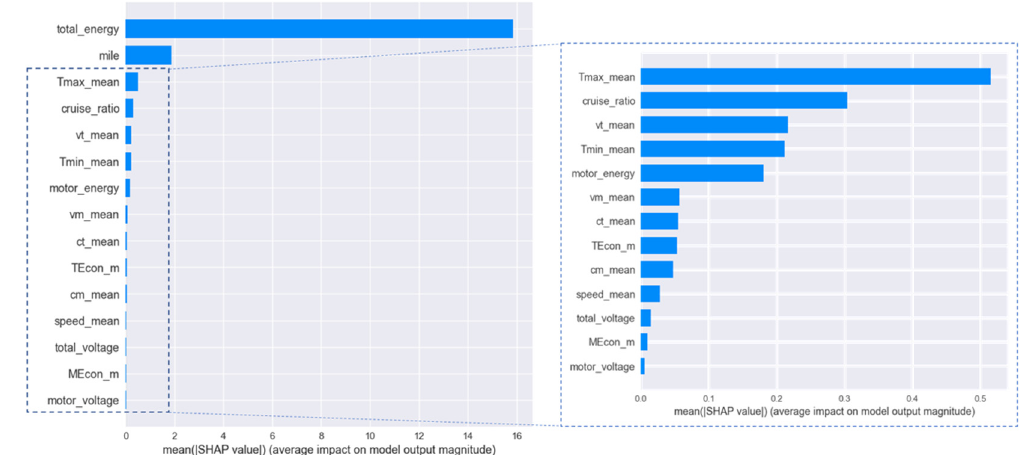
Figure 7. Mean value ranking of SHAP values characteristic.